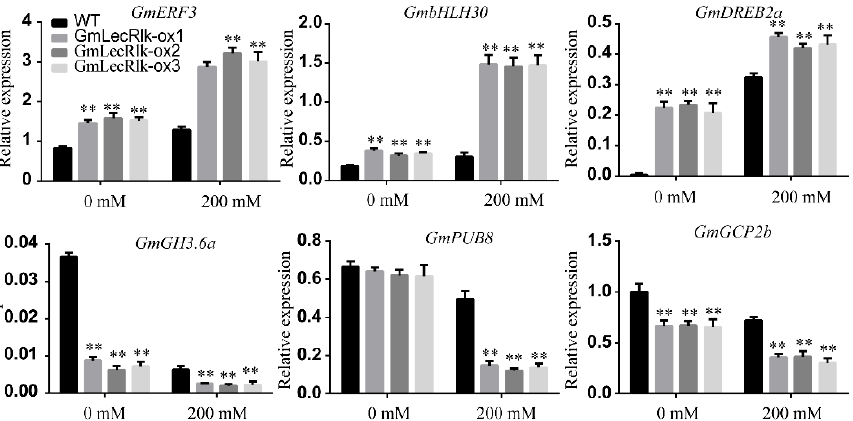
Figure 6. The transcriptional levels of GmERF3 , GmbHLH30 , GmDREB2a , GmGH3 . 6a , GmPUB8 , and GmGCP2 in GmLecRlk-ox and WT soybean under 0 or 200 mM NaCl for 12 h. **, GmLecRlk -ox soybean showed a significant difference from the WT ( p < 0.01). Error bars,